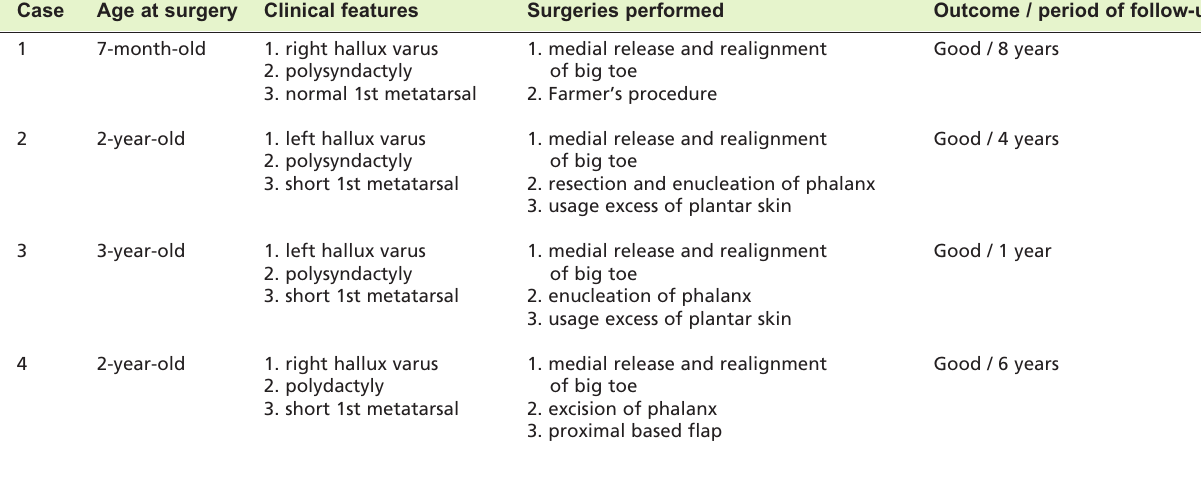
Summary on the age at time of surgery, clinical features, types of reconstructive surgery performed, outcome and Table I: